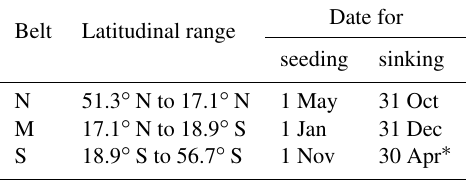
Table 2. Latitudinal division of MOS deployment regions.